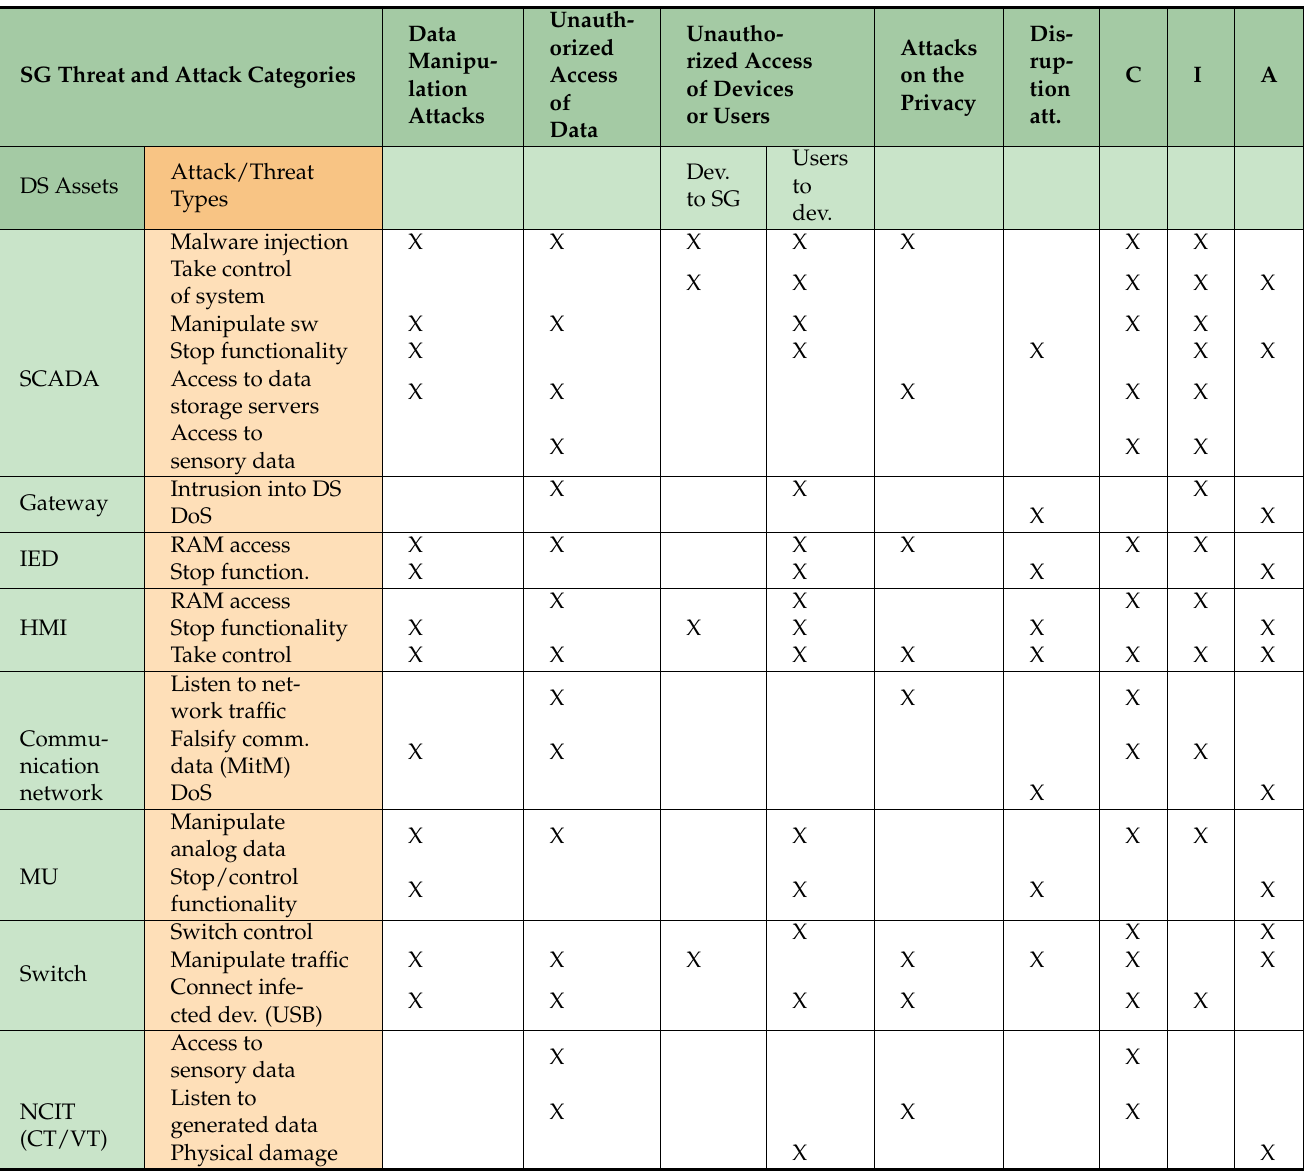
Table 2. The Security Table resulting from linking Threat and Attack Categories to the Security Map. Adapted from